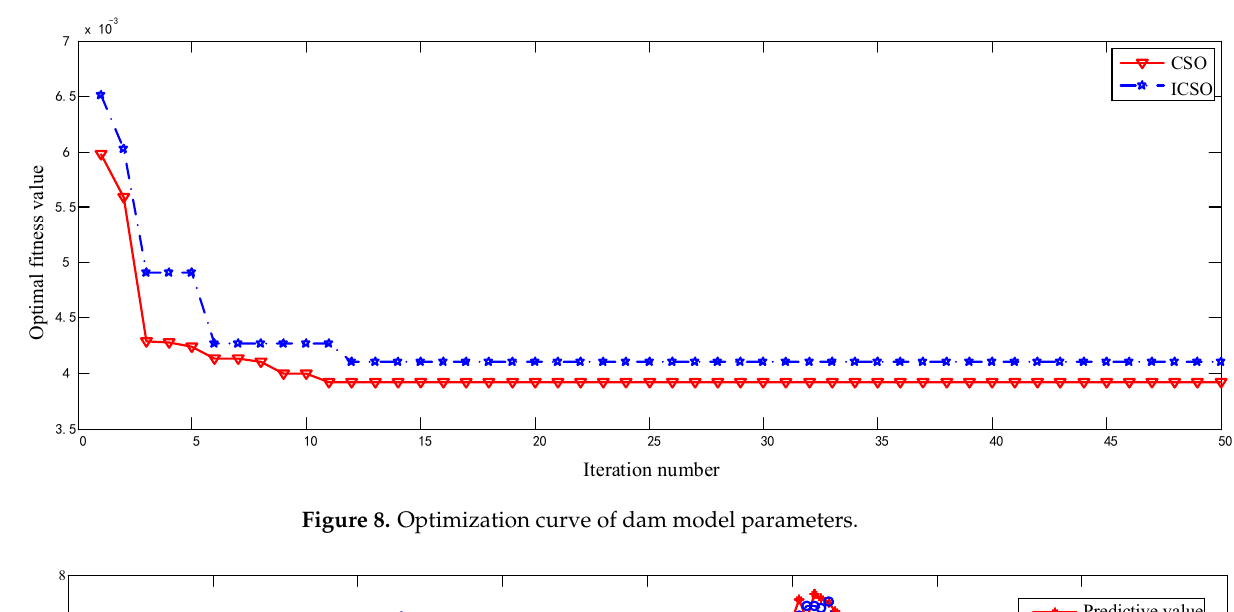
Figure 8. Optimization curve of dam model parameters.